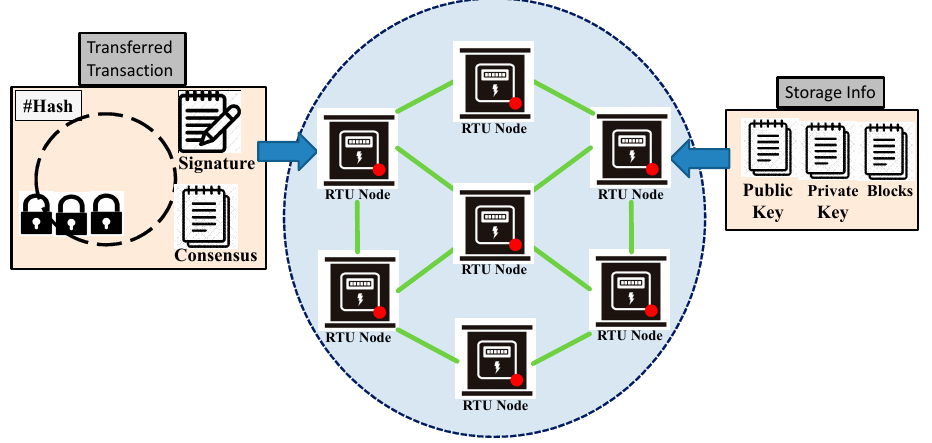
Figure 6. Encryption process in active remote terminal unit (RTU) nodes during transaction.